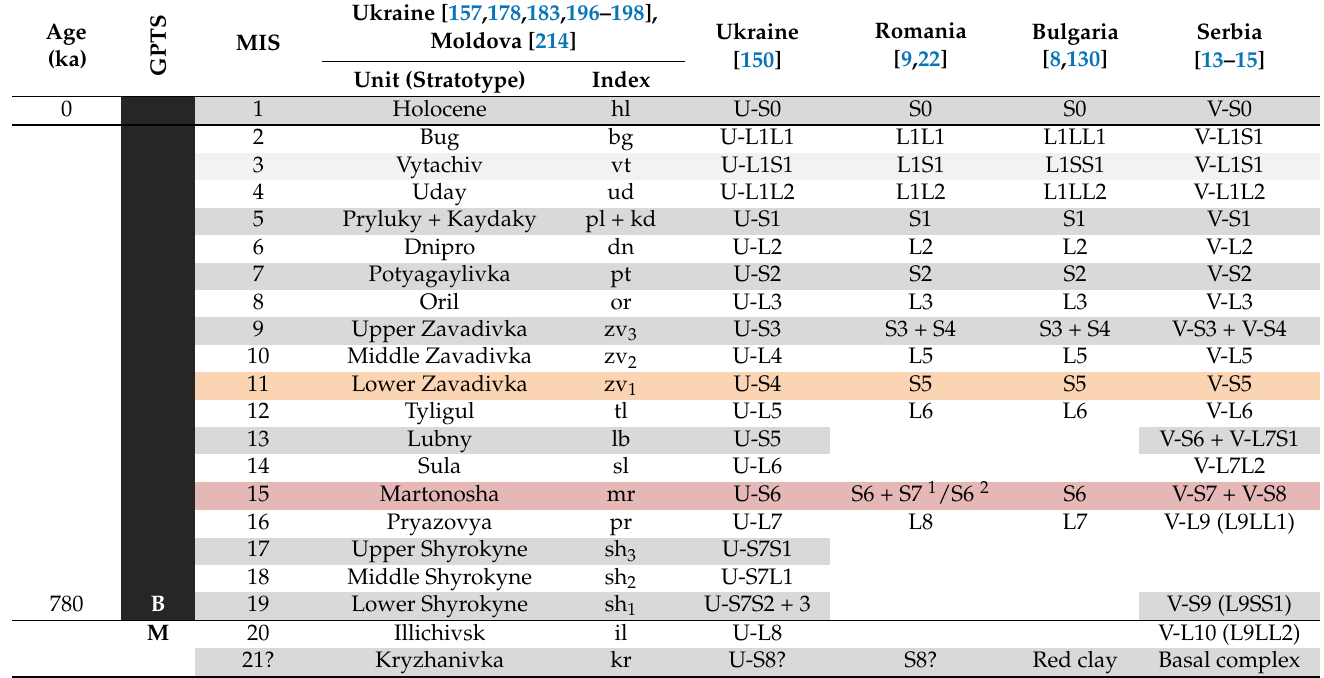
Table 5. The proposed correlation between national loess stratigraphies in eastern and south-eastern Europe (since the Middle Pleistocene), its relation to marine isotope stages and Geomagnetic Polarity Time